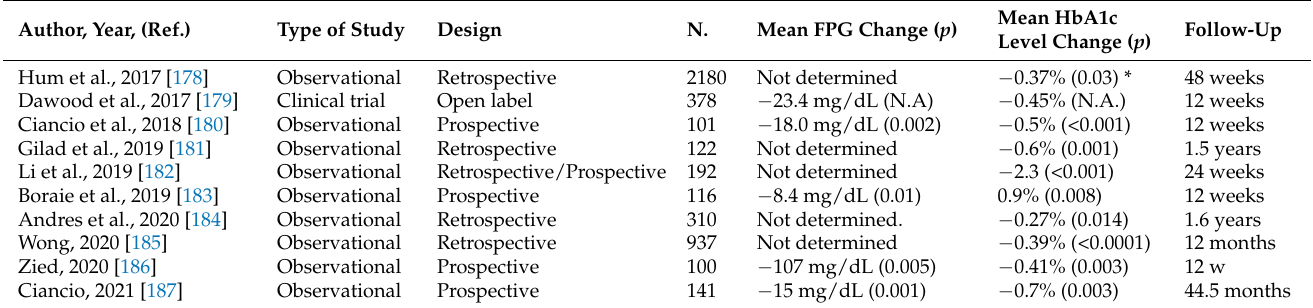
Table 2. Studies recruiting ≥ 100 HCV-positive diabetic patients and reporting significant gly- cometabolic amelioration after successful therapy with